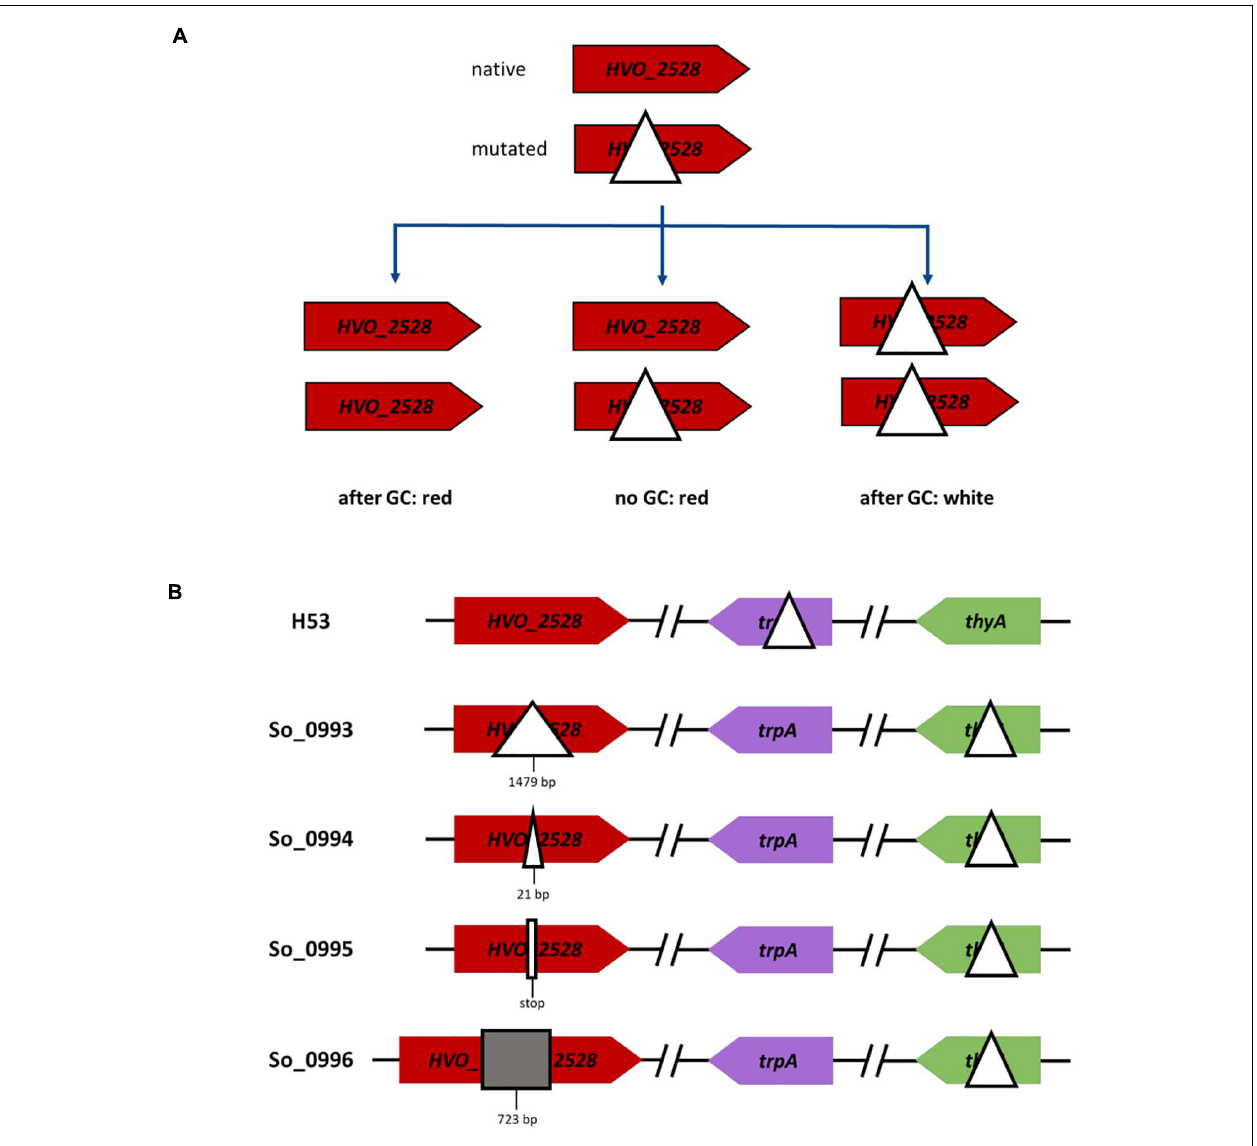
FIGURE 6 | Schematic overview of gene conversions experiments involving the wildtype genome and genomes with various modifications at one site. (A) The versions of gene HVO_2528 in the two parent strains are shown on top, the three possible output strains are shown below. (B) Overview of one parent strain (on top) and the four versions of the second parent strain (below), which contained different mutations in gene HVO_2528